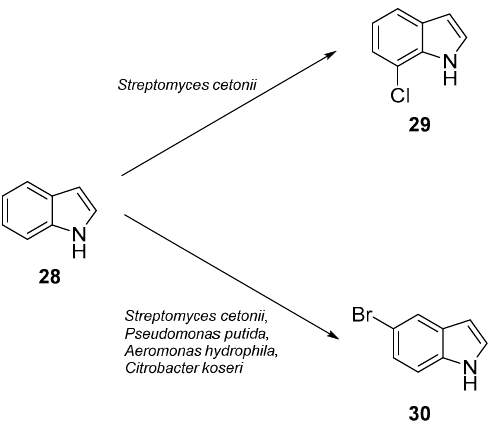
Figure 13. Halogenation of indole ( 28 ) nucleobase analogs according to Lewkowicz and co-workers [87].